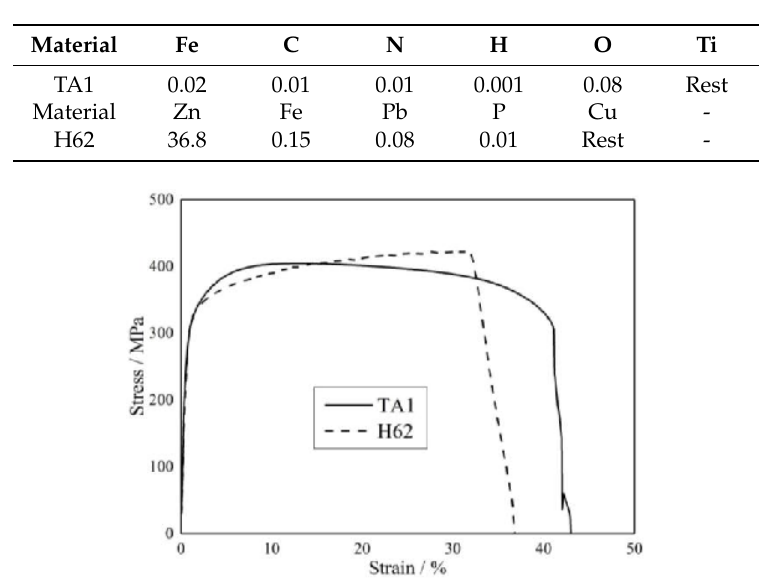
Table 1. Chemical compositions of TA1 and H62 sheet materials.